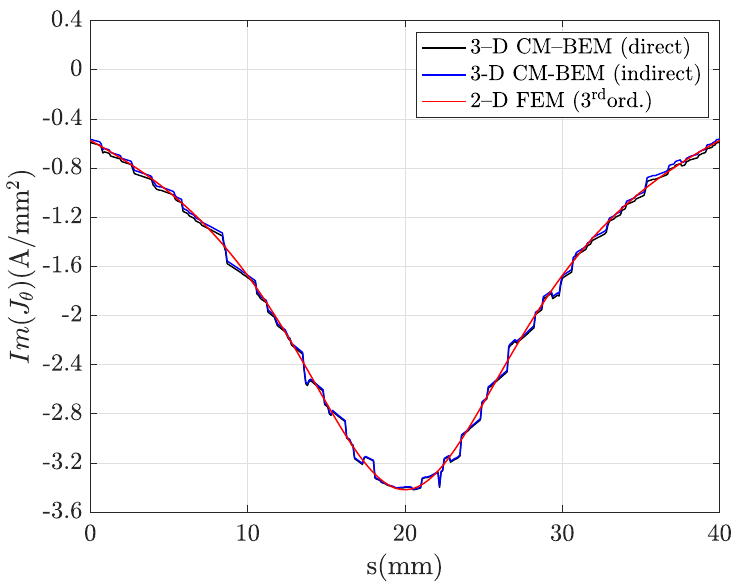
Figure 5. Imaginary part of the azimuthal current density component along line A-B (black line: direct formulation, blue line: indirect formulation, red line: 2D FEM, taken as a reference).